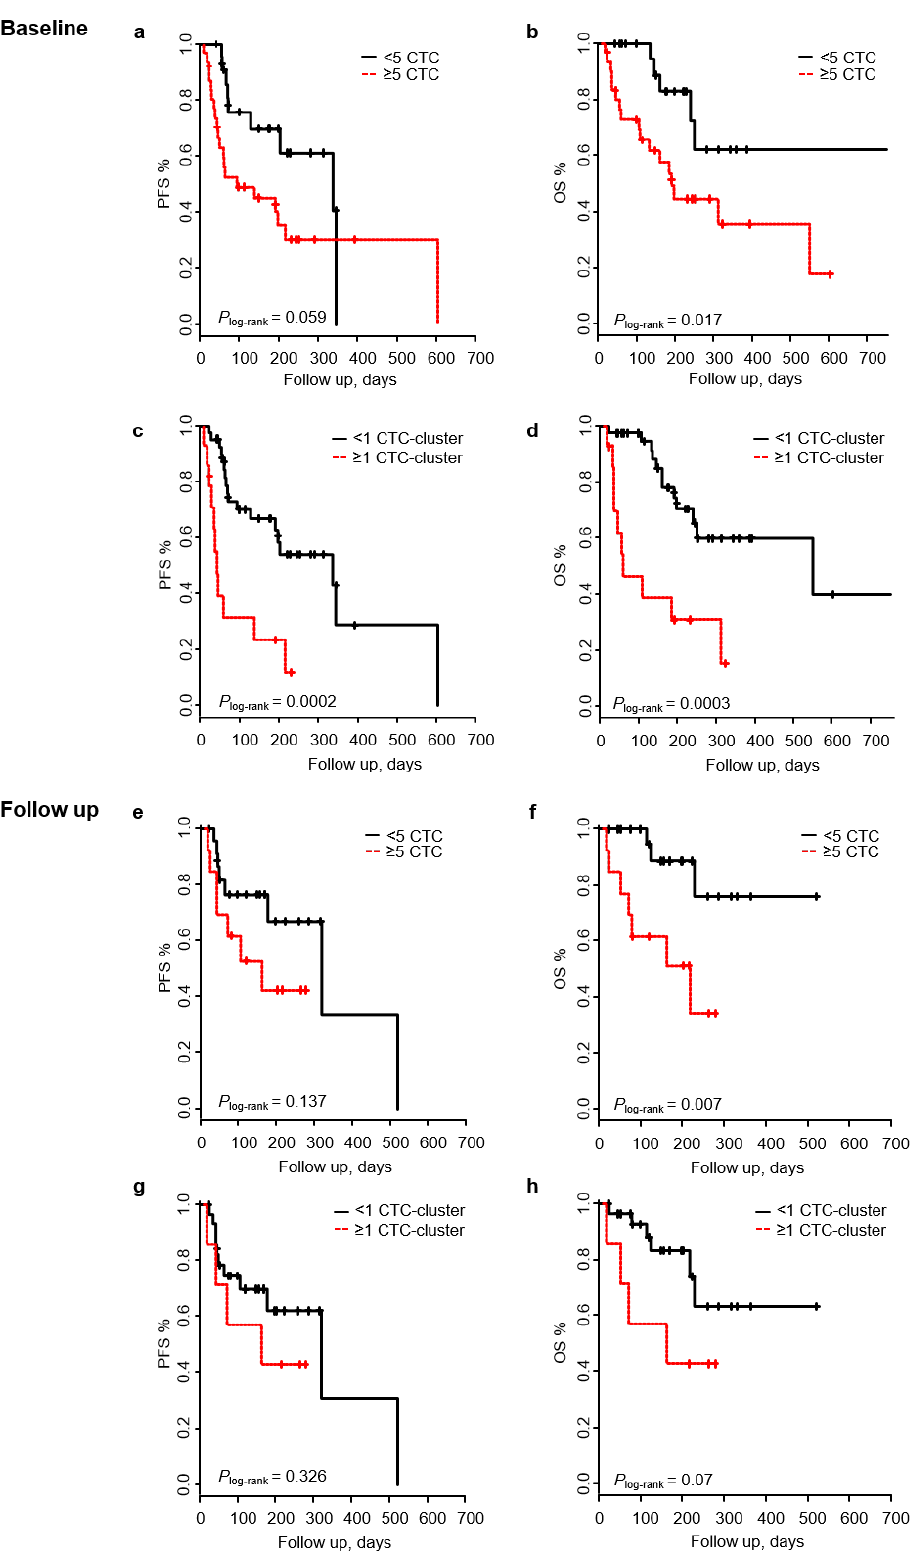
Figure 2. CTCs and CTC-clusters at baseline and follow up, in relation to progression-free survival (PFS) and overall survival (OS). Kaplan–Meier curves displaying PFS and OS at baseline based on CTC count ( ≥ 5 CTCs / 7.5 ml of blood) ( a , b ) and CTC-cluster count ( ≥ 1 CTC-cluster / 7.5 mL of blood) ( c , d ), and at follow up based on CTC count ( e , f ) and CTC-cluster count ( g , h ).